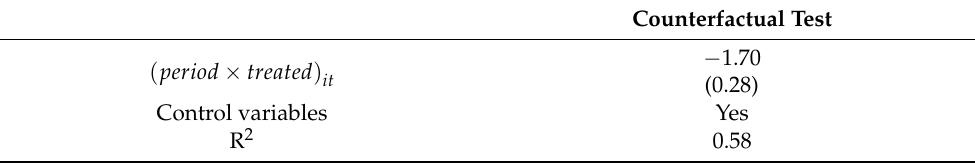
Table 5. The result of counterfactual